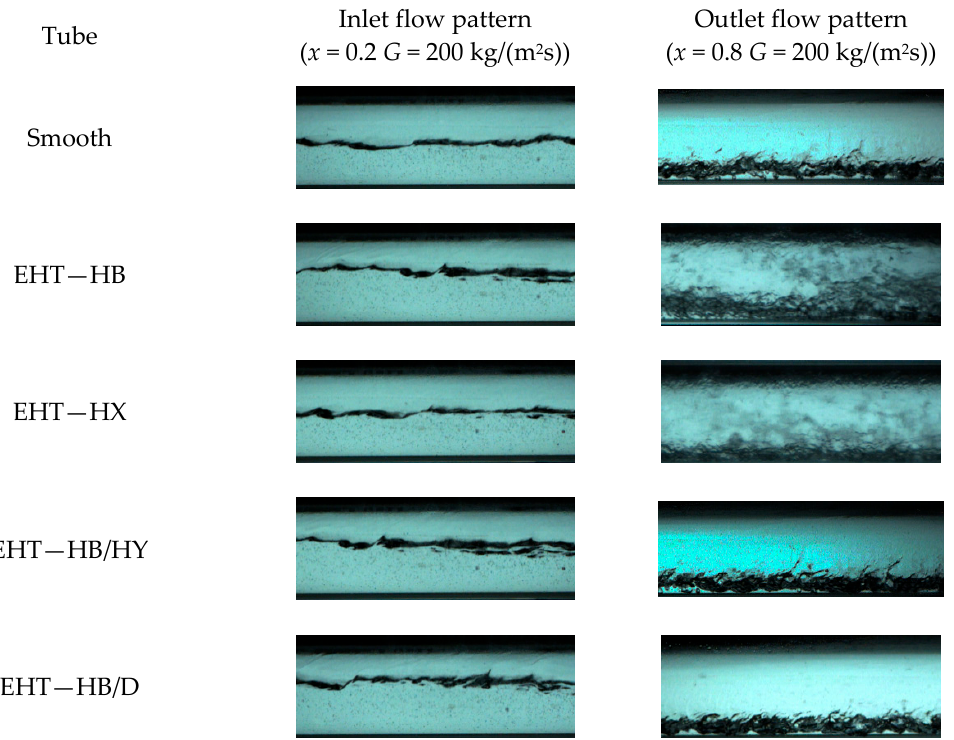
Figure 9. Evaporation flow patterns for the tested tubes at the inlet and outlet ( G = 200 kg/(m 2